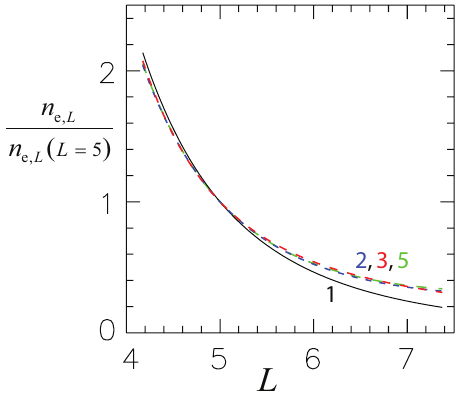
Fig. 11. The L d dependence of n e , n e ,L at L d = 5 is shown for fit 1 (solid black curve), fit 2 (blue dashed curve), fit 3 (red dashed curve), and fit 5 (green dashed